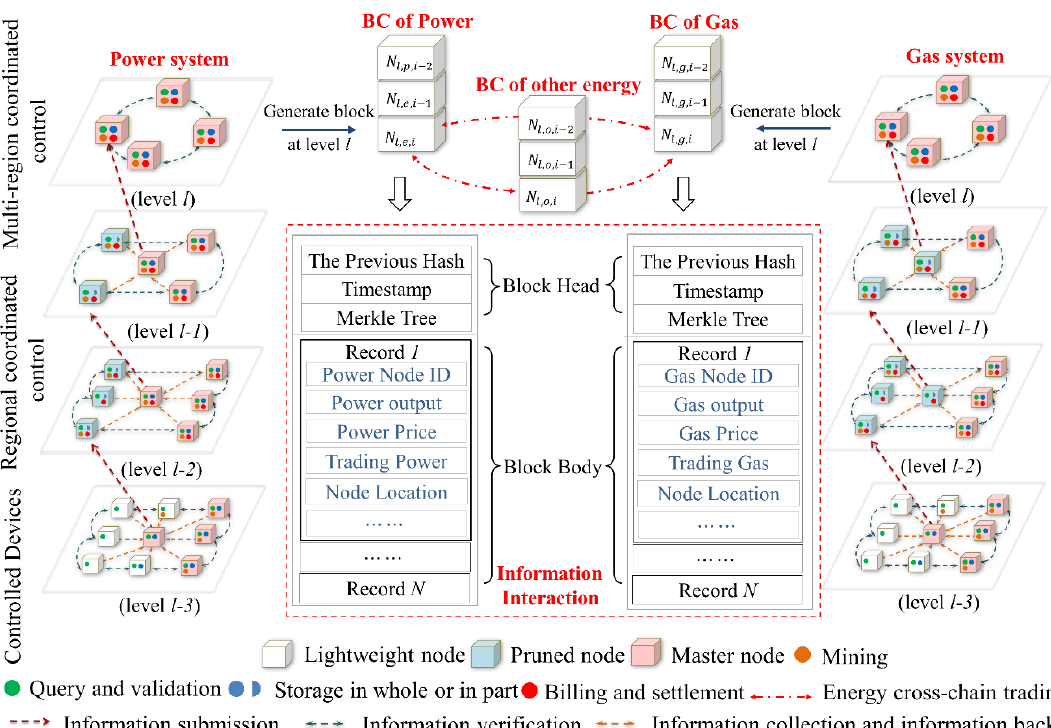
Figure 4. The multilevel and multichain information transmission model of energy internet based on blockchain.